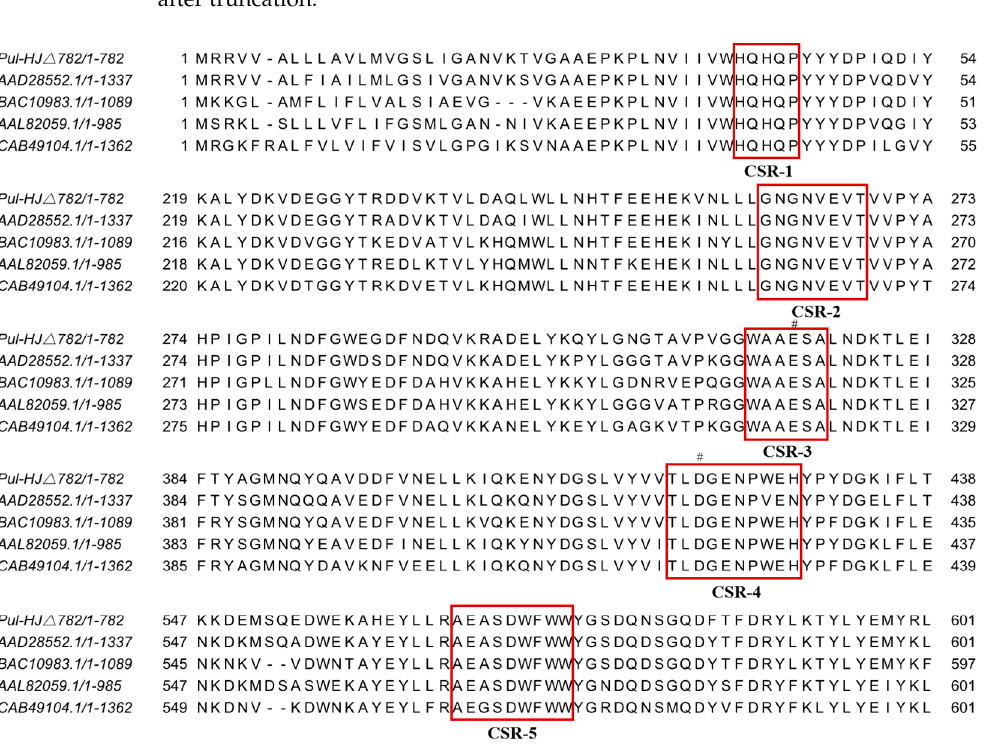
Figure 6. ( a ) B-factor values of Pul-HJ21 and Pul-HJ ∆ 782; ( b ) the loop region with reduced B-value after truncation.